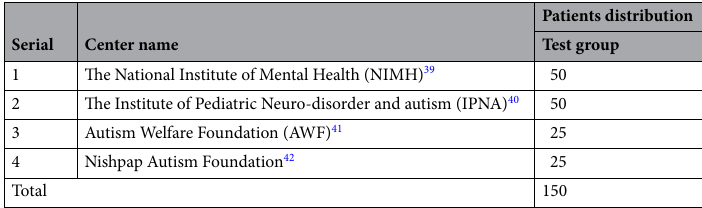
Table 1. The patient distribution among the four centers.